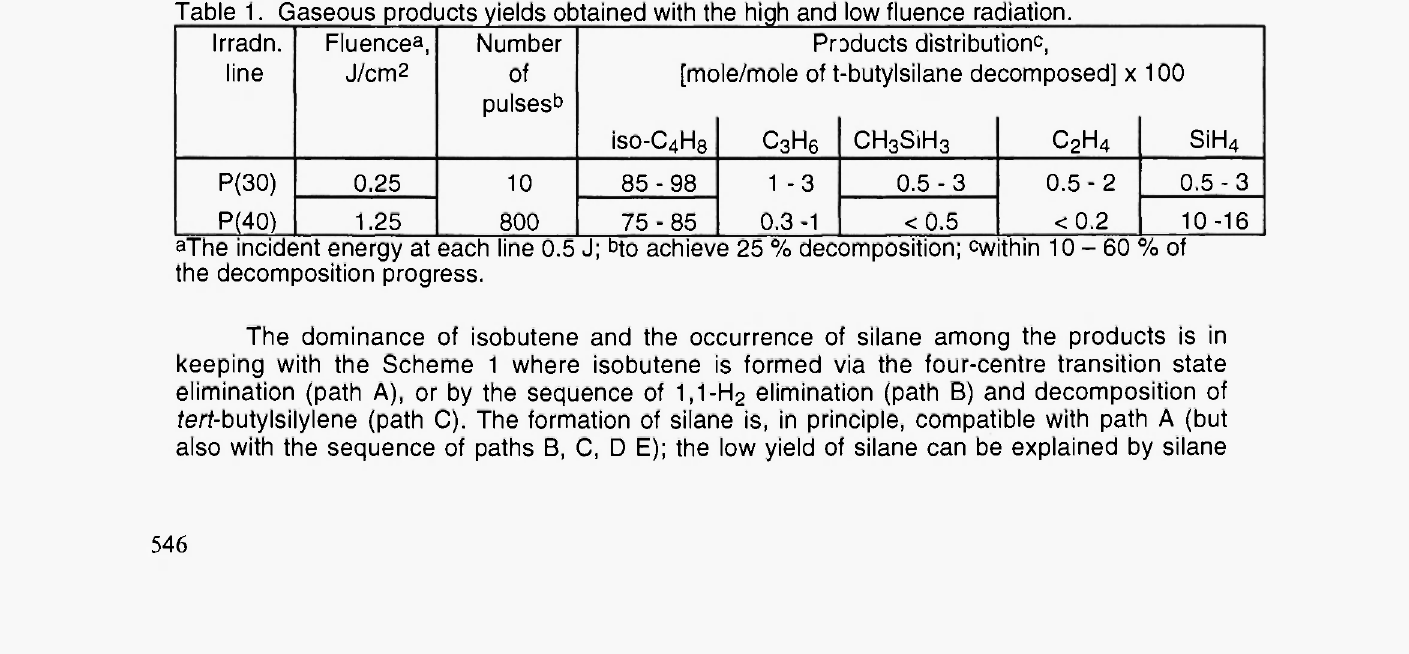
Table 1. Gaseous products yields obtained with the high and low fluence radiation.